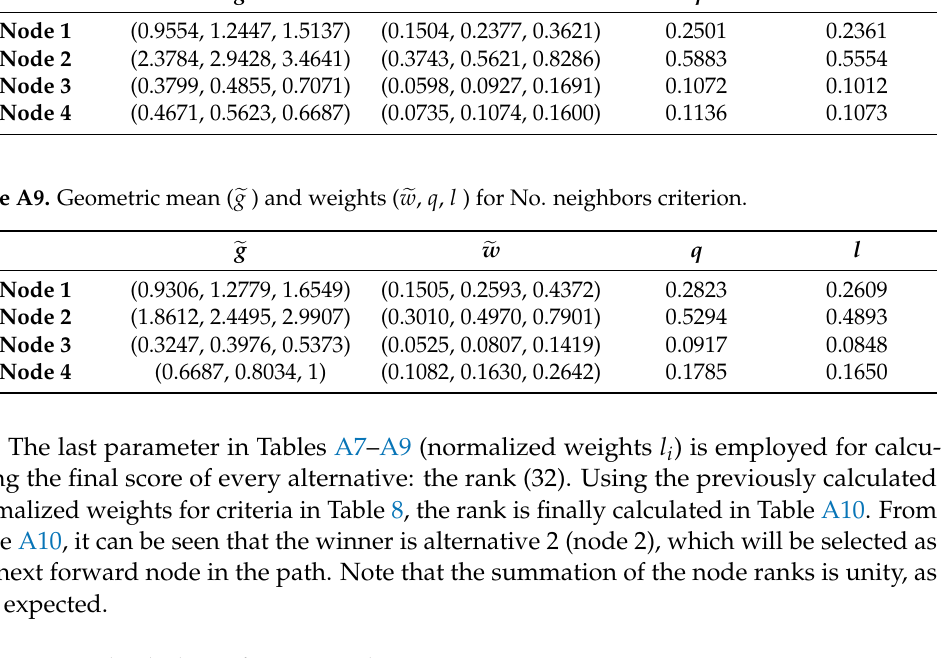
Table A10. Rank calculation for every